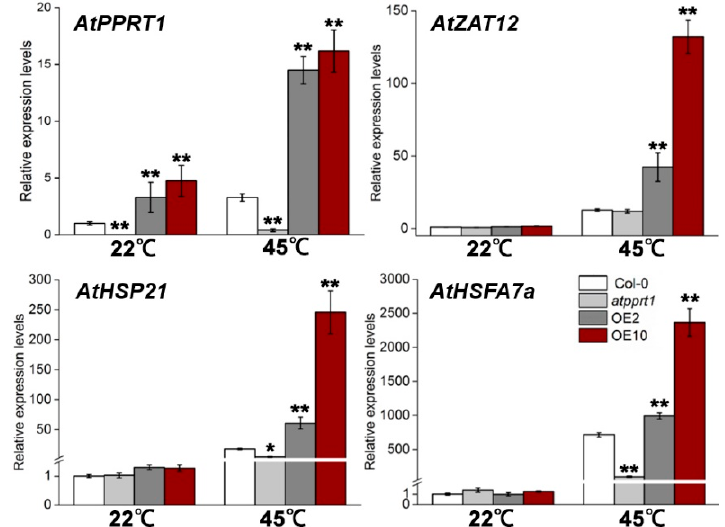
Figure 5. Transcript levels of heat stress-responsive genes were analyzed. Changes of AtPPRT1 , AtZAT12, AtHSP21 and AtHSFA7a in each line were analyzed by qRT-PCR before and after heat stress treatment. Error bars represent ± SD ( n = 3, * p < 0.05, ** p < 0.01, t -test).